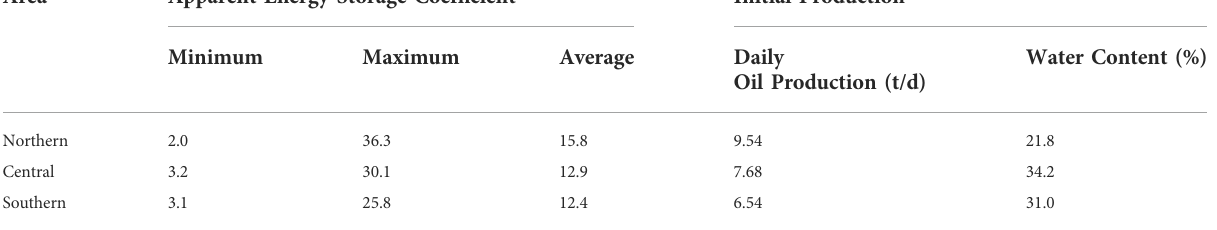
TABLE 2 Statistical results of reservoir coef fi cient in the Chang 7 Member of the study